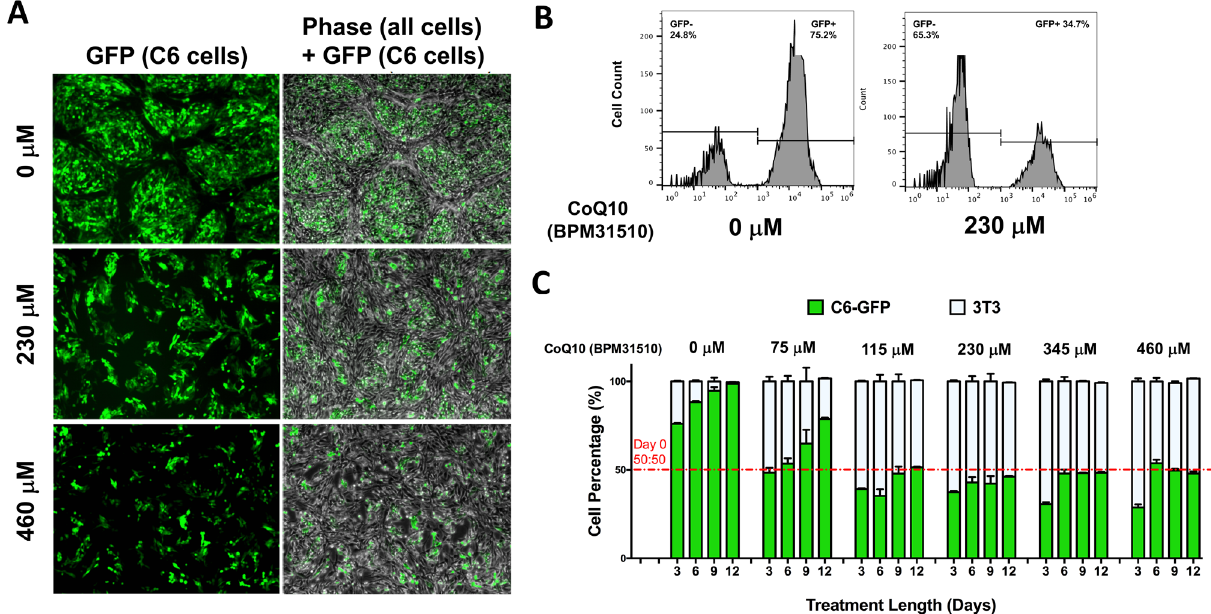
Figure 4. Ubidecarenone induces differential effects on cell growth and redox vulnerabilities between non- tumor and glioblastoma cells in co-culture. ( A ) Phase and fluorescent images of GFP-labeled rat C6 glioma cells and non-labeled mouse NIH3T3 fibroblast, co-cultured and treated with 0, 230, or 460 µM ubidecarenone, demonstrates a dose-dependent decrease in glioma cells with a relative sparing of HA cells. (B ) Flow cytometry analysis (scatter plot) of GFP and O 2 − in GFP-labeled rat C6 glioma cells and non-labeled mouse NIH3T3 co-culture. Cell populations are characterized based on GFP intensity. Note the increase in the GFP neg population relative to GFP high population in the presence of ubidecarenone. ( C ) Flow cytometry analysis of GFP- labeled rat C6 glioma cells and non-labeled mouse NIH3T3 fibroblasts co-cultures treated with ubidecarenone for up to 12 days. Cells are characterized based on their GFP intensity (GFP neg or GFP pos ). Results are grouped based on ubidecarenone dose and are shown as a percentage of the entire cell population. While glioma cells (GFP pos ) represent the entire cell population by day 9 in co-cultures without ubidecarenone, there are essentially equal numbers of glioma and non-tumor cell populations at doses ≥ 115 µM